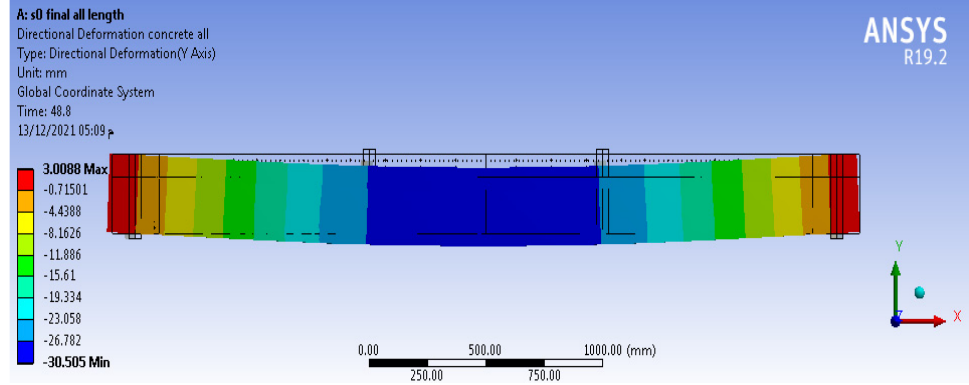
Figure 14. Vertical deflection at the failure of specimen S0.